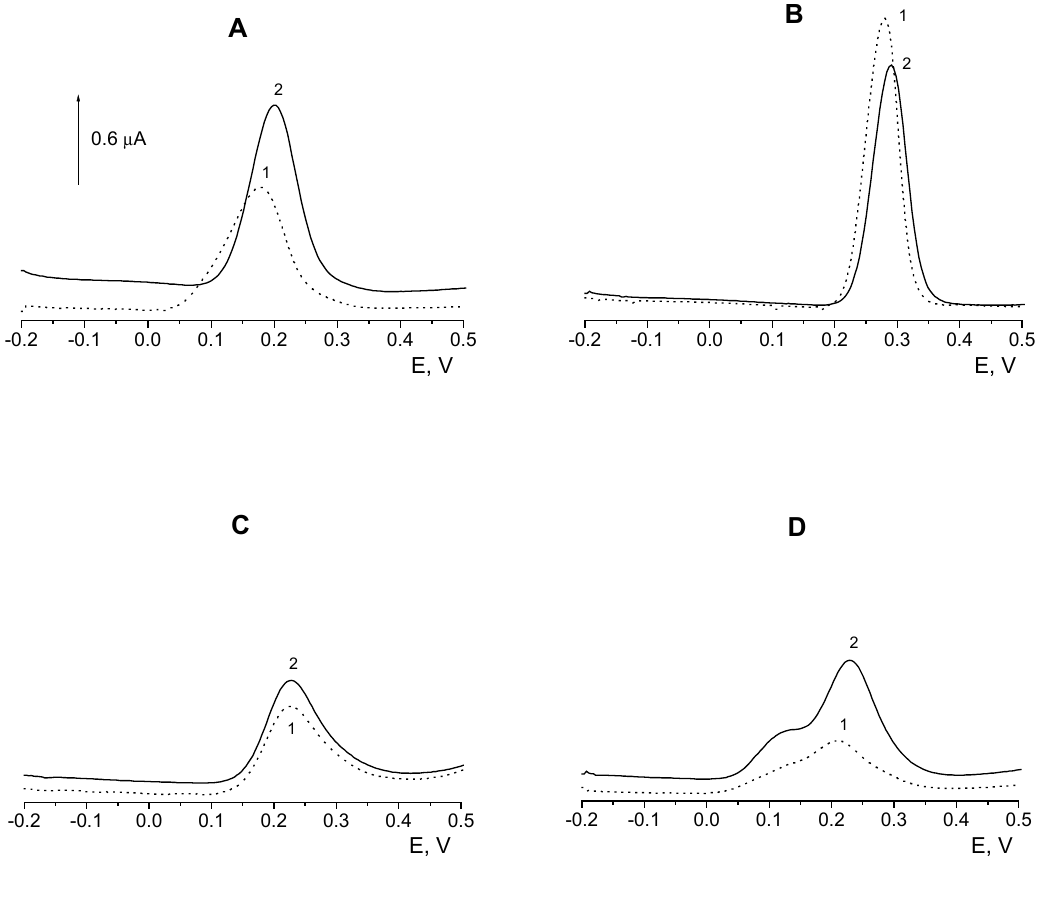
Figure 1. DP voltammograms of the flavonoids measured at CPE (1) and DNA/CPE (2) after 5 min accumulation at open circuit in solution of 5 × 10 -7 mol/l quercetin (A), 5 × 10 -7 mol/l rutin (B), 5 × 10 -5 mol/l catechin (C) and 5 × 10 -6 mol/l epigallocatechin gallate (D). Conditions: 5 mmol/l phosphate buffer solution pH 7.0 with 1 % DMSO, pulse amplitude 100 mV, scan rate 25 mV/s, room temperature of 22